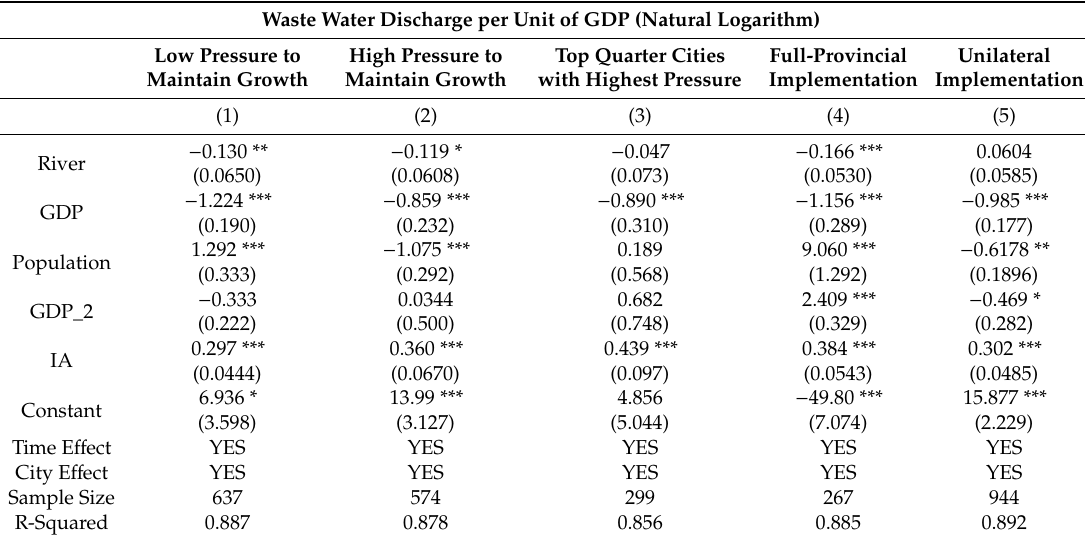
Table 4. Challenges associated with the implementation of the RCS (partial regression